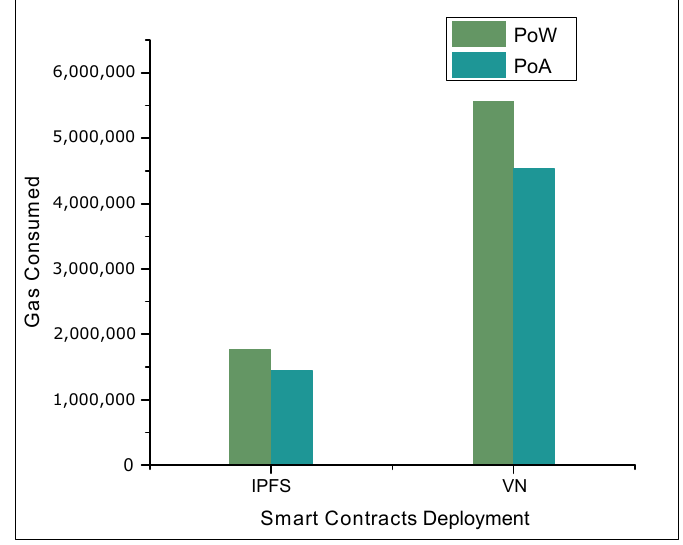
Figure 3. Smart Contracts Deployment